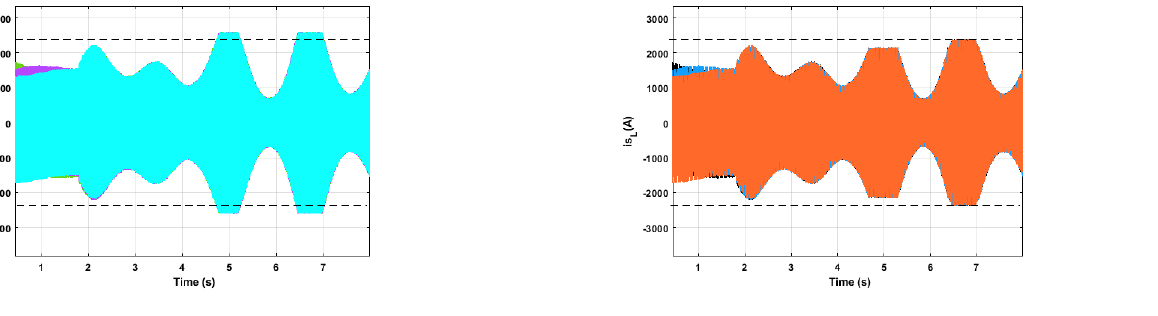
Figure 8g. Stator Current without Power management Figure 8h. Stator Current with Power management